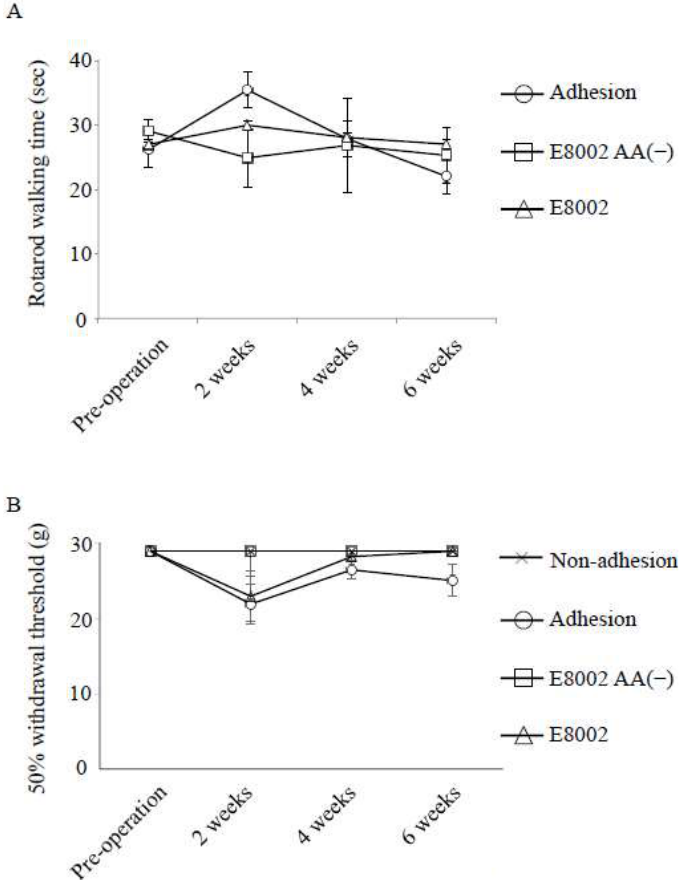
Figure 5. Effect of the E8002 membrane on neurological function. ( A ) Motor function was examined by rotarod walking time (s) ( n = 7 rats per group). There are no data for the non-adhesion group because this group comprised the healthy limbs of a randomly selected subset of the total rats used. Values are mean ± SE; n.s., non-significant determined by an ANOVA or the Kruskal–Wallis test followed by the Bonferroni–Dunn correction. Time course was analyzed by a repeated measures ANOVA or the Friedman test. ( B ) Mechanical sensitivity determined by the 50% withdrawal threshold (g) ( n = 7 hindlimbs per group). After surgery, the adhesion group developed mechanical hypersensitivity. Values are mean ± SE; n.s., non-significant determined by a one-way ANOVA or the Kruskal–Wallis test followed by the Bonferroni–Dunn correction. Time course was analyzed by a repeated measures ANOVA or the Friedman test.